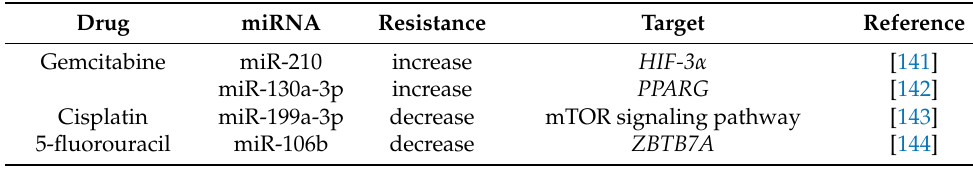
Table 4. miRNAs in cholangiocarcinoma therapy